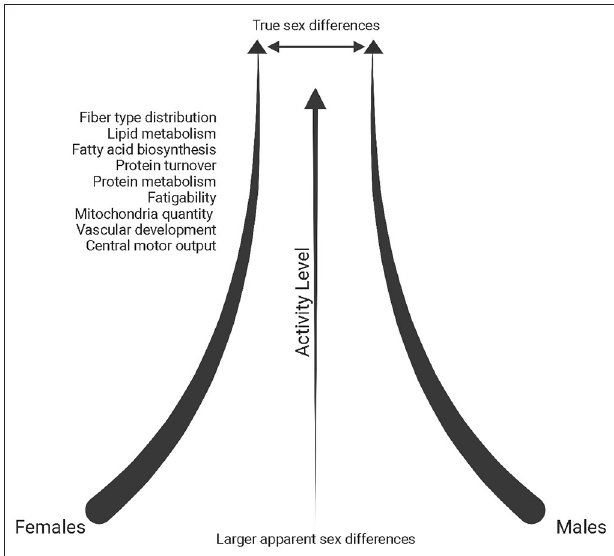
FIGURE 3 | Schematic of the reduction in sex differences reported in the literature ( throughout text ) with increasing physical activity levels. Created with